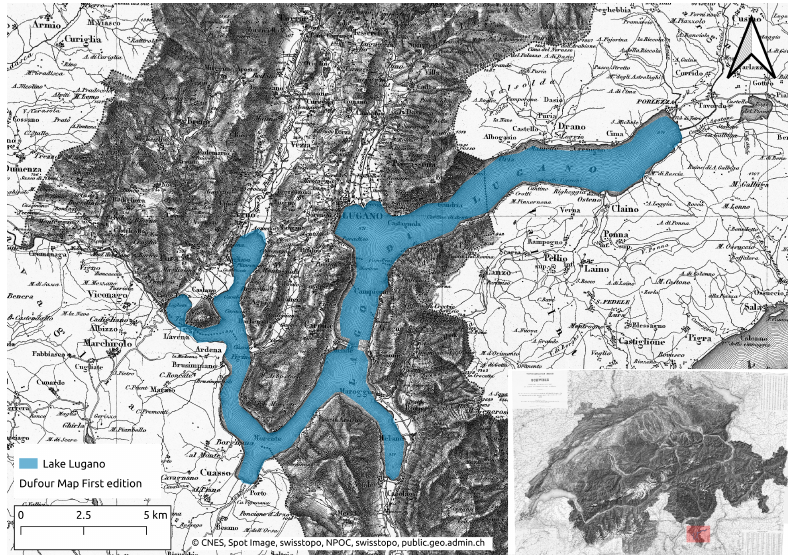
Figure 1. Map of Lake Lugano, southern part of Switzerland. Table 1. Morphometric information about Lake